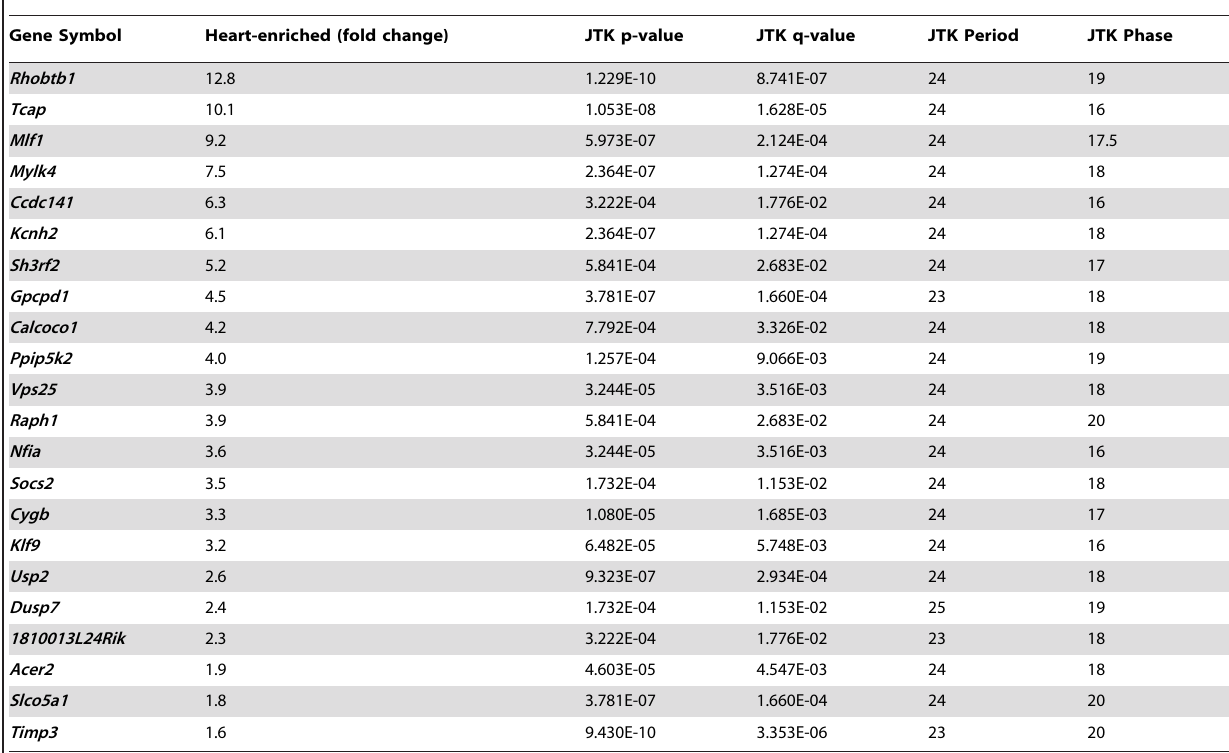
Table 2. The 22 Rhythmic Genes Highly Expressed in Heart vs. 96 Murine Tissues.